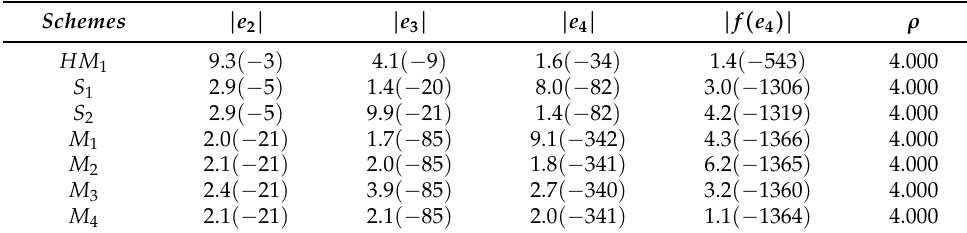
Table 5. Numerical results of function f 5